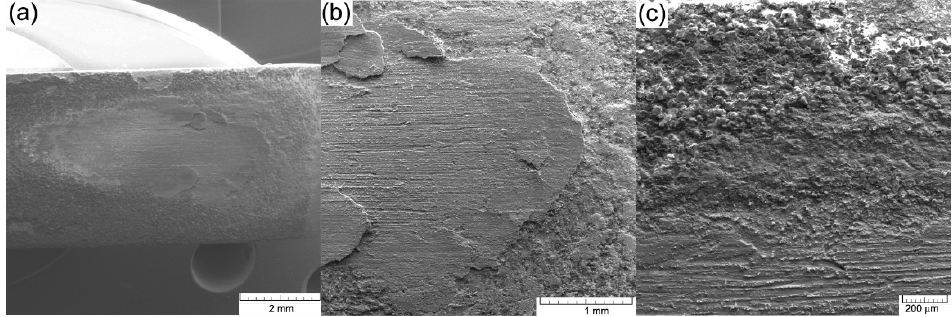
Figure 9. SEM images of the worn zone during the test: ( a ) wear trace; ( b ) detail of the wear end area; ( c ) wear edge.